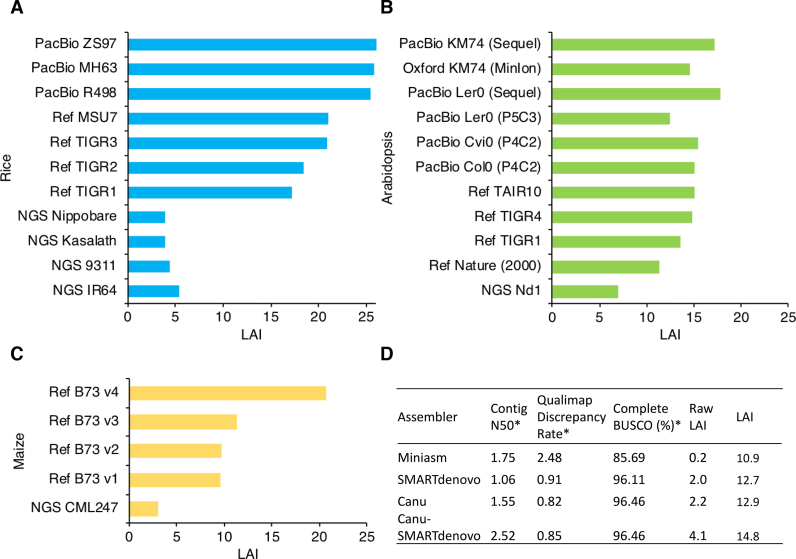
LTR Assembly Index of model plant genomes. LAI score of (A) rice genomes, (B) Arabidopsis genomes, and (C) maize genomes. Reference genomes were labeled as Ref with version number indicated. All reference genomes were sequenced by the Sanger-based BAC-by-BAC approach, with the exception of the maize genome Ref B73 v4, which was generated through the PacBio long-read sequencing technique. NGS, next-generation sequencing. PacBio, PacBio long-read sequencing. Oxford, Oxford Nanopore long-read sequencing. (D) Four versions of the Solanum pennellii genome assembled using different assemblers with the same batch of Oxford Nanopore sequencing data. *Data adapted from Schmidt et al.(16).